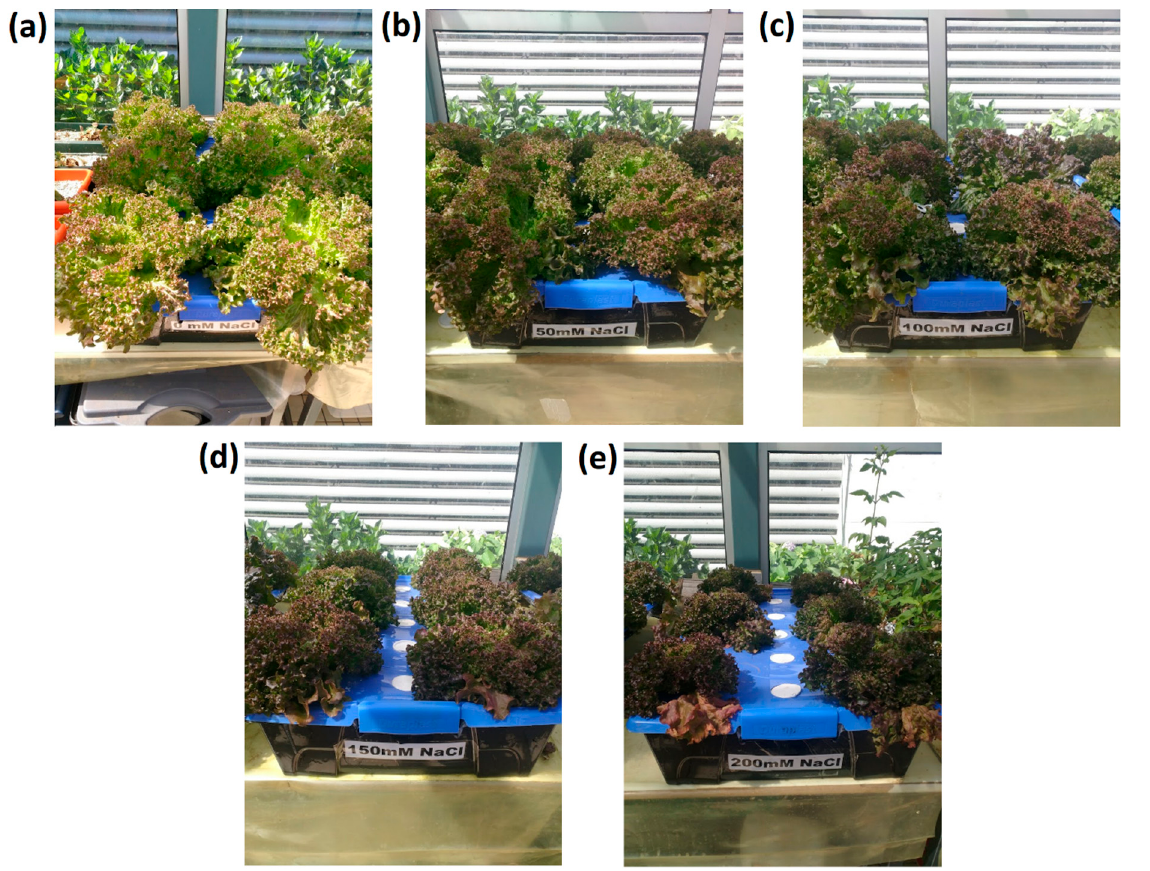
Figure 2. Morphological visual comparison of red lettuce plants ( Lactuca sativa Lollo Rosso cv. ‘CARMOLI’) growing at: ( a ) 0 mM NaCl, ( b ) 50 mM NaCl, ( c ) 100 mM NaCl, ( d ) 150 mM NaCl, and ( e ) 200 mM NaCl in a hydroponic system.